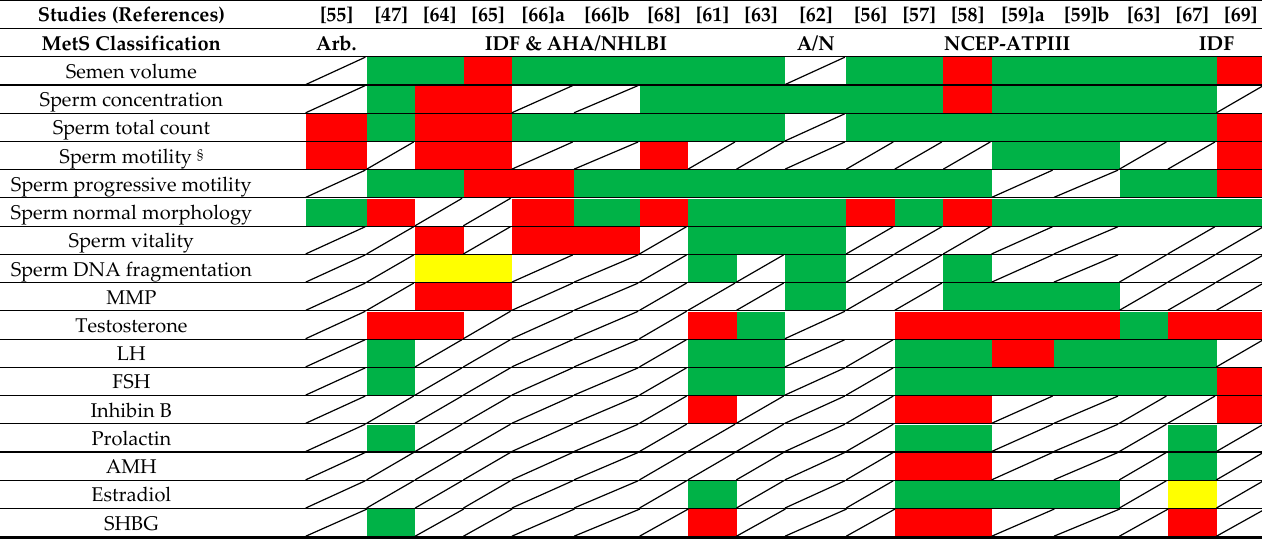
Table 5. Schematic representation of the associations found in cross-sectional studies between MetS, seminal and hormonal parameters.